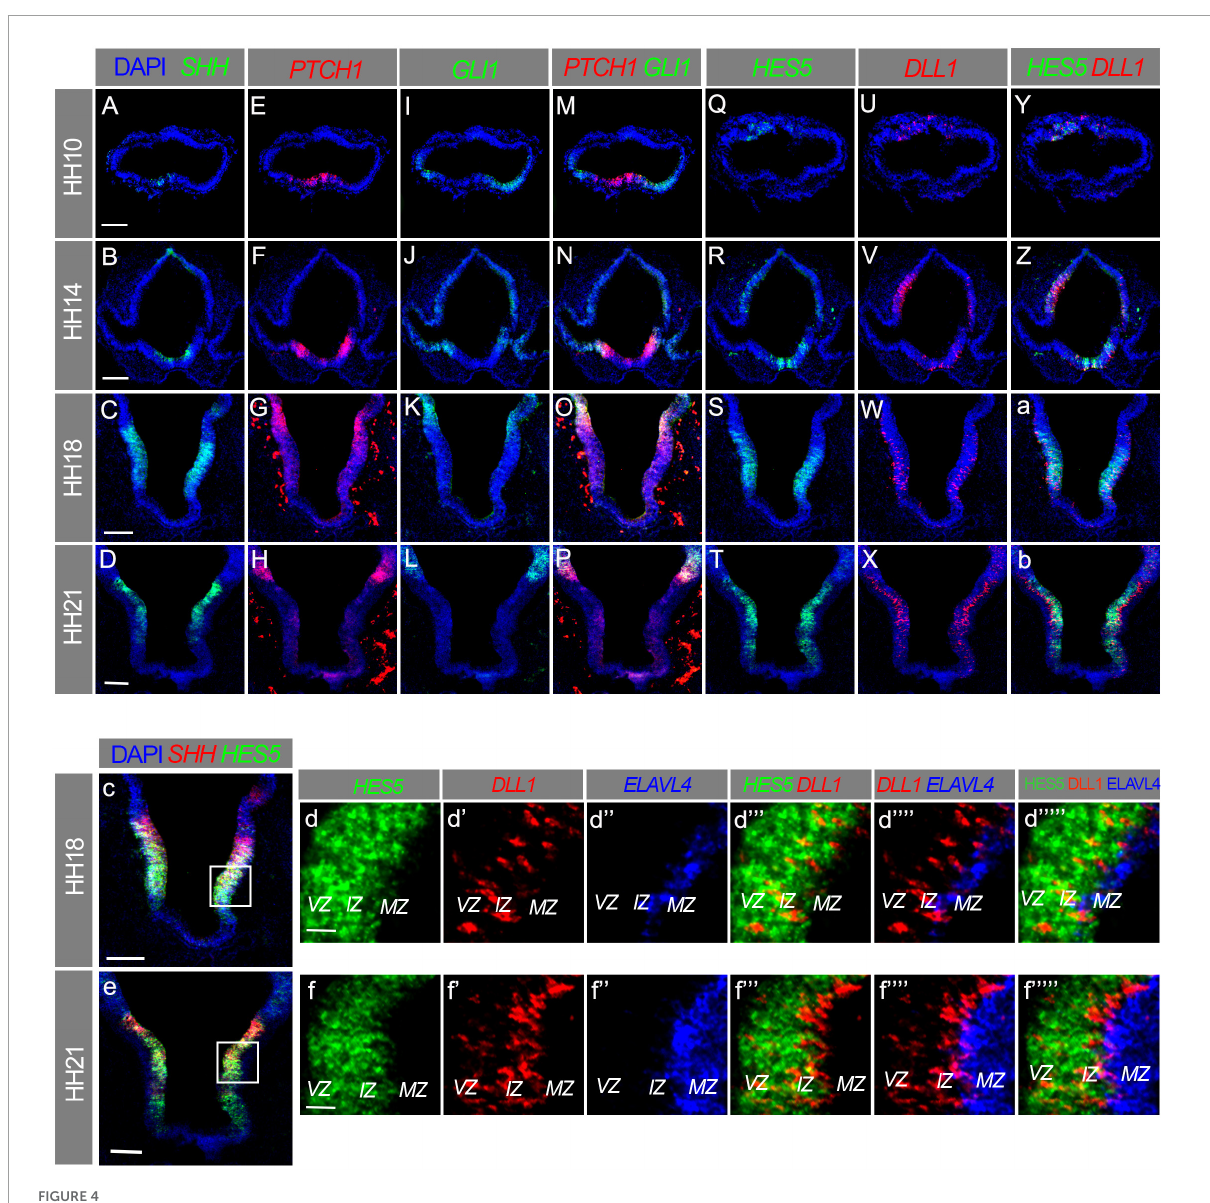
FIGURE4 (A–f””’) Transverse sections through hypothalamus of HH10 (A,E,I,M,Q,U,Y) , HH14 (B,F,J,N,R,V,Z) , HH18 (C,G,K,O,S,W,a,c,d–d””’) , and HH21 (D,H,L,P,T,X,b,e,f–f””’) embryos, in situ HCR labelled for SHH , PTCH1 , GLI1 , HES5 , DLL1 , and ELAVL4 . Boxes in panels (c,e) indicate area expanded in panels (d–d””’,f–f””’) . VZ, ventricular zone; IZ, intermediate zone; MZ, mantle zone. Scale bars = 100 µ m (A–D,c,e) , 25 µ m (d,f)